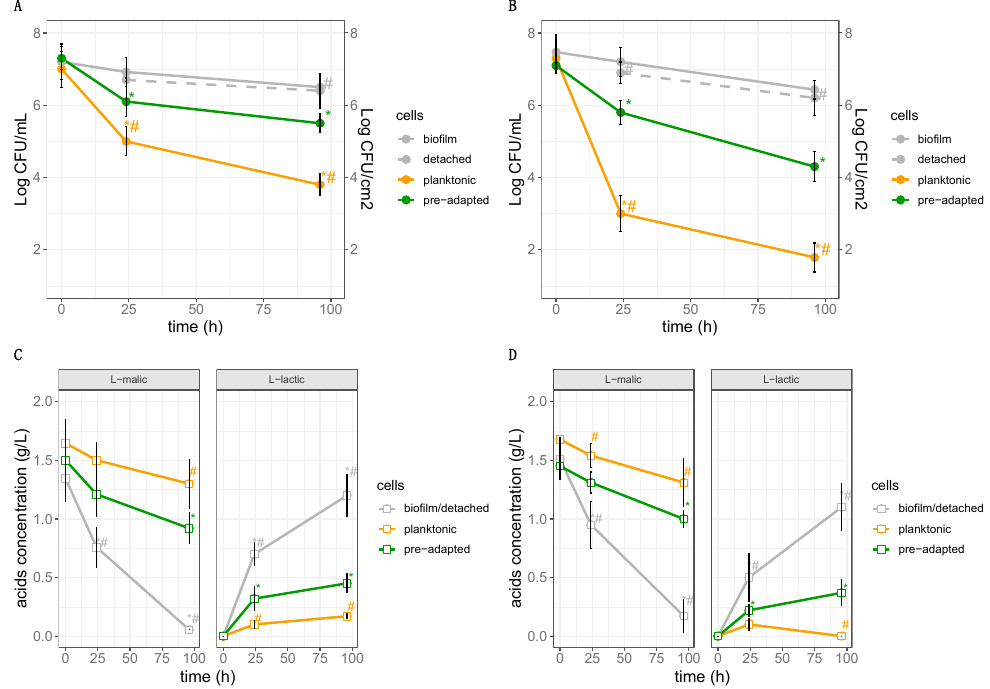
Figure 7. Survival of planktonic cells, biofilm cells, detached cells from biofilm, and pre-adapted cells of L. plantarum Lpls22 inoculated at high concentration in MW at ( A ) pH 3.5 and ( B ) pH 3.2. Trend of L-malic and L-lactic acid in MW at ( C ) pH 3.5 and ( D ) pH 3.2 inoculated with biofilm cells, planktonic cells, or pre-adapted cells of L. plantarum Lpls22. Data are reported as mean values with standard deviation of three biological replicates. * indicates significant ( p < 0.05) di ff erences compared with 0 h. # indicates significant ( p < 0.05) di ff erences compared with pre-adapted cells at the same time.